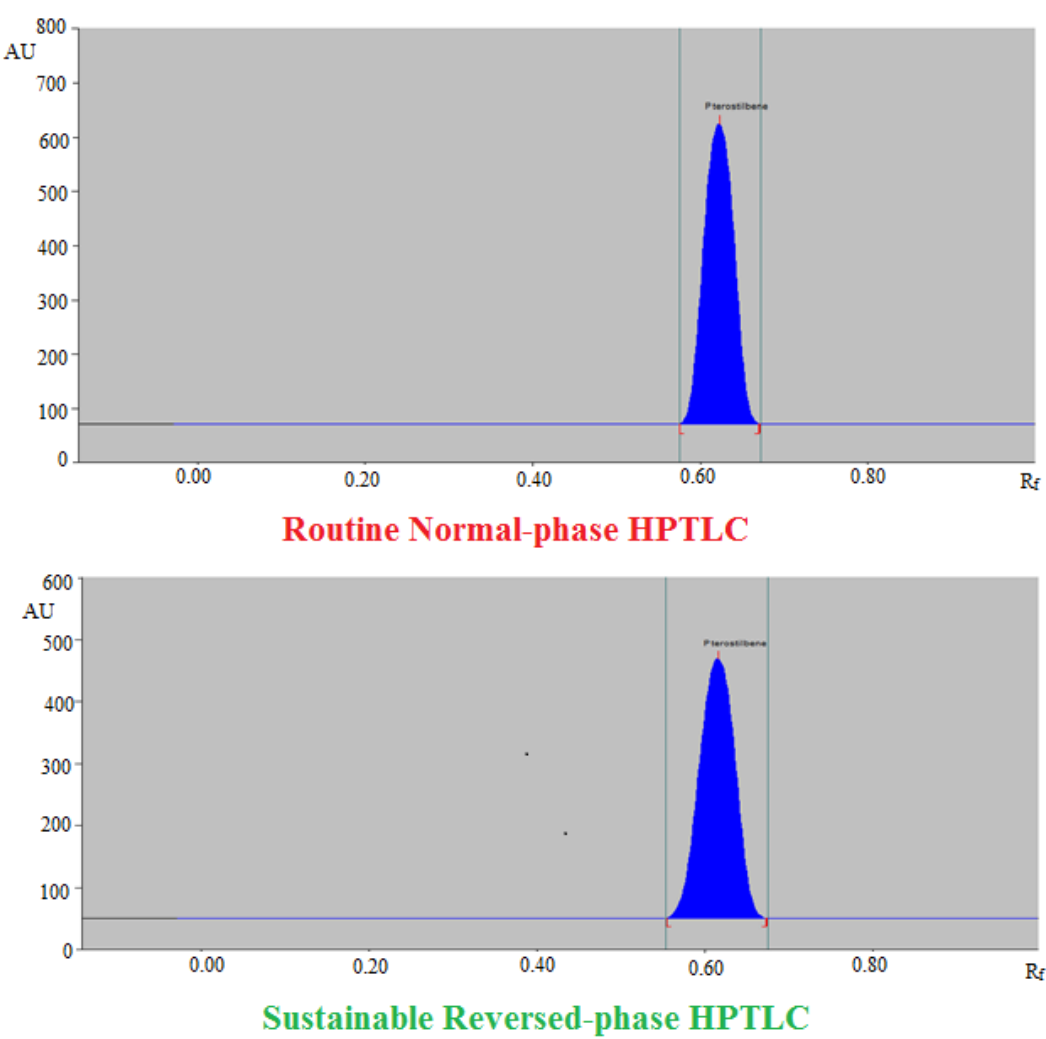
Figure 1. Representative spectrodensitograms of standard pterostilbene (PT) recorded using routine normal-phase high- performance thin-layer chromatography (HPTLC) and sustainable reversed-phase HPTLC techniques.